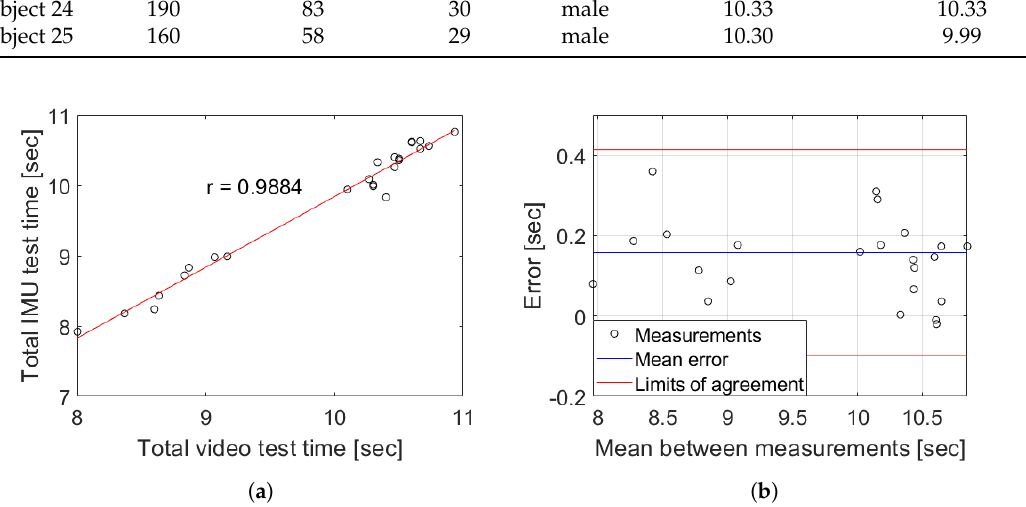
Figure 12. Results from the measurements obtained by the proposed methodology versus the typical visual clinical procedure in young subjects. ( a ) Pearson correlation between IMU and the video record analysis; ( b ) Bland–Altman plot between IMU and the video record